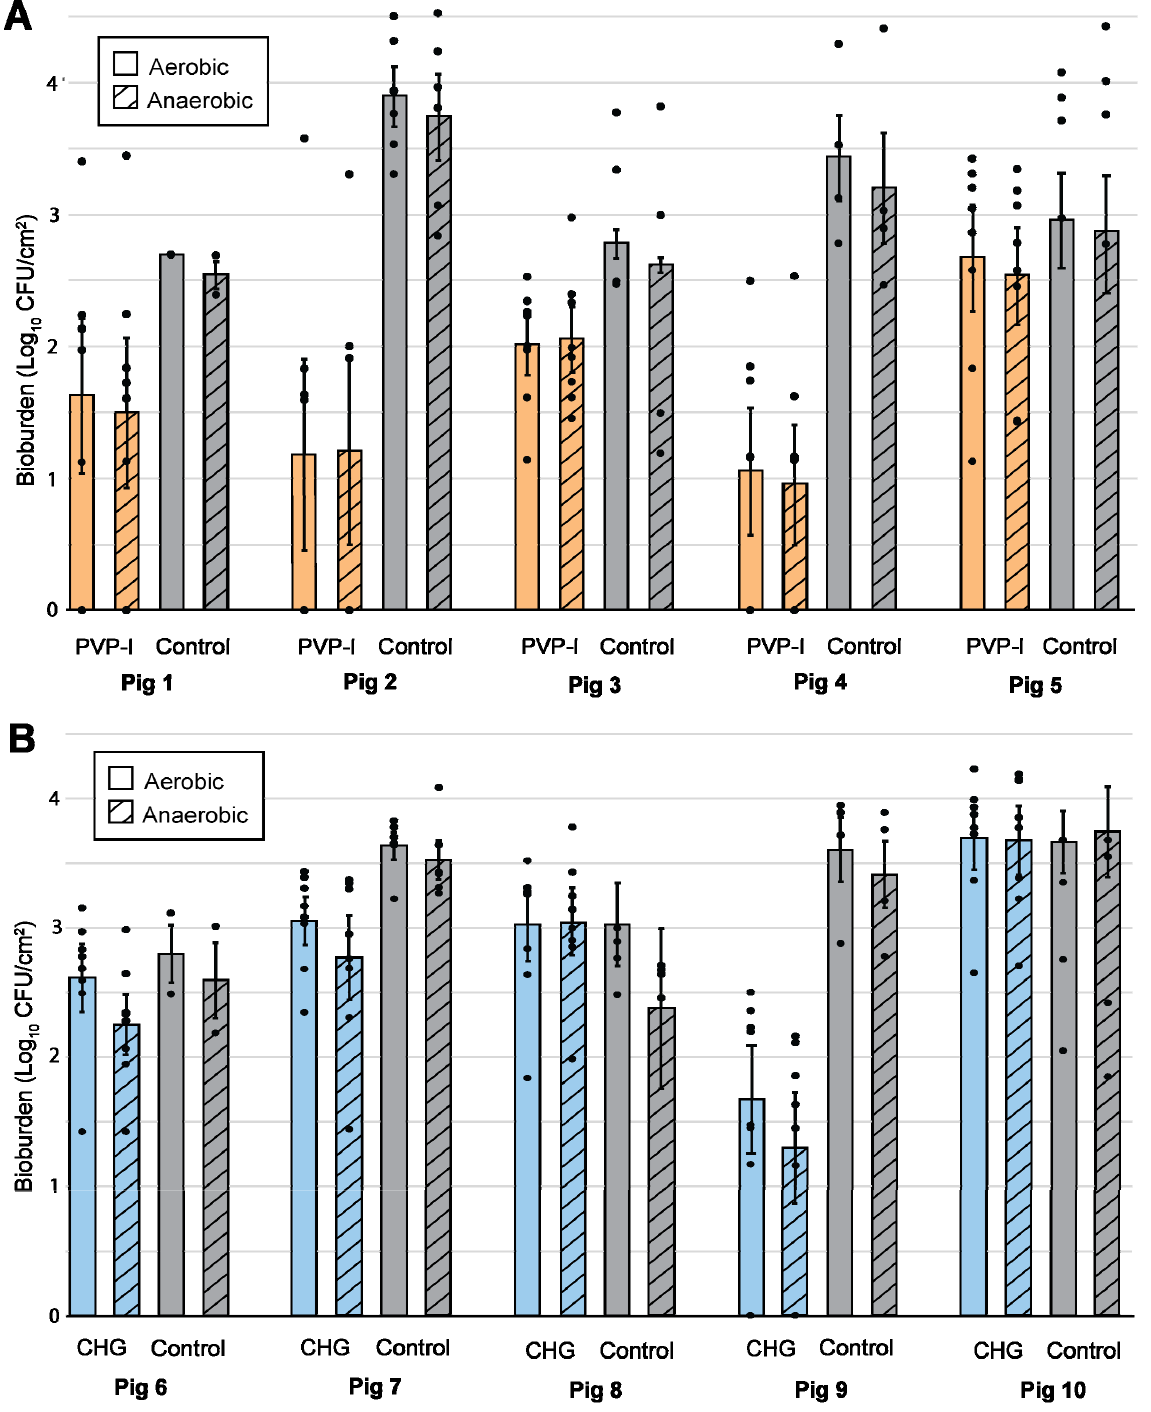
Figure 4. The log 10 -transformed bioburden of the tissue samples collected following PSP compared to the control samples. Each bar is a representation of the average per pig with the points representing the individual tissue samples. Each PSP bar has 8 points from eight tissue samples while each control bar has 2–6 points respective of the number of samples taken. A solid bar indicates aerobic culture conditions while hatching indicates anaerobic culture conditions. ( A ) Pigs 1–5 received a PVP-I scrub (Orange). ( B ) Pigs 6–10 received a CHG scrub (Blue). The error bar shows ±